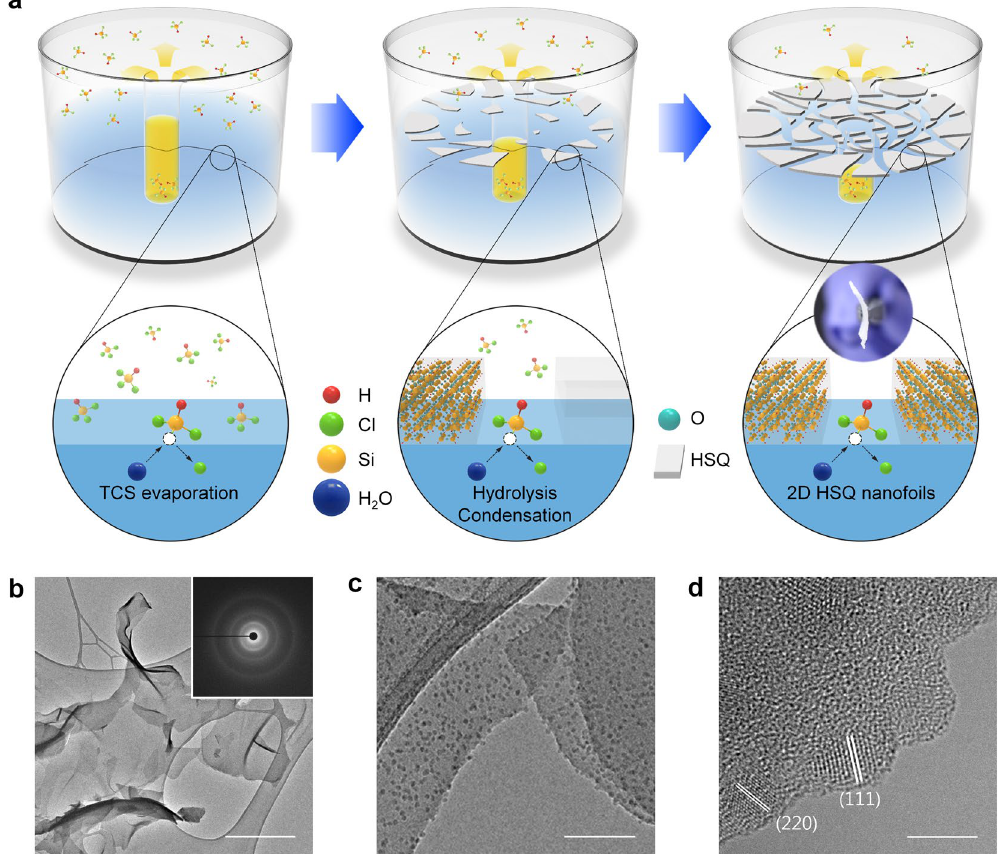
Figure 1. Schematic illustration of 2D HSQ nanofoil preparation process and structural characterization of 2D Si/SiO x nanofoils. ( a ) 2D HSQ nanofoils synthesized using sol-gel reaction in a home-made reactor, and 2D Si/SiO x nanofoils after heat treatment of as-prepared 2D HSQ nanofoils at 1000 °C; ( b ) low-magnification TEM image with a corresponding selected area diffraction pattern (SADP) (inset), ( c ) high-magnification TEM image, and ( d ) HRTEM image of 2D Si/SiO x nanofoils. Scale bar, ( b ) 1 μ m, ( c ) 100 nm, and ( d ) 5